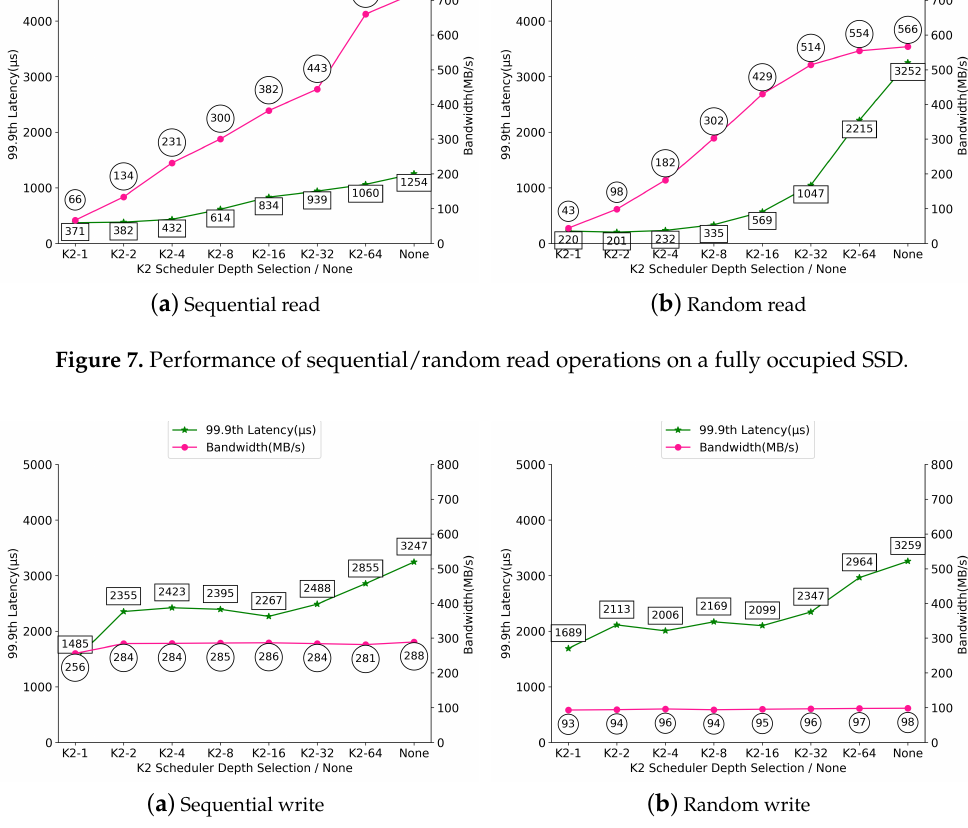
Figure 8. Performance of sequential/random write operations on a fully occupied